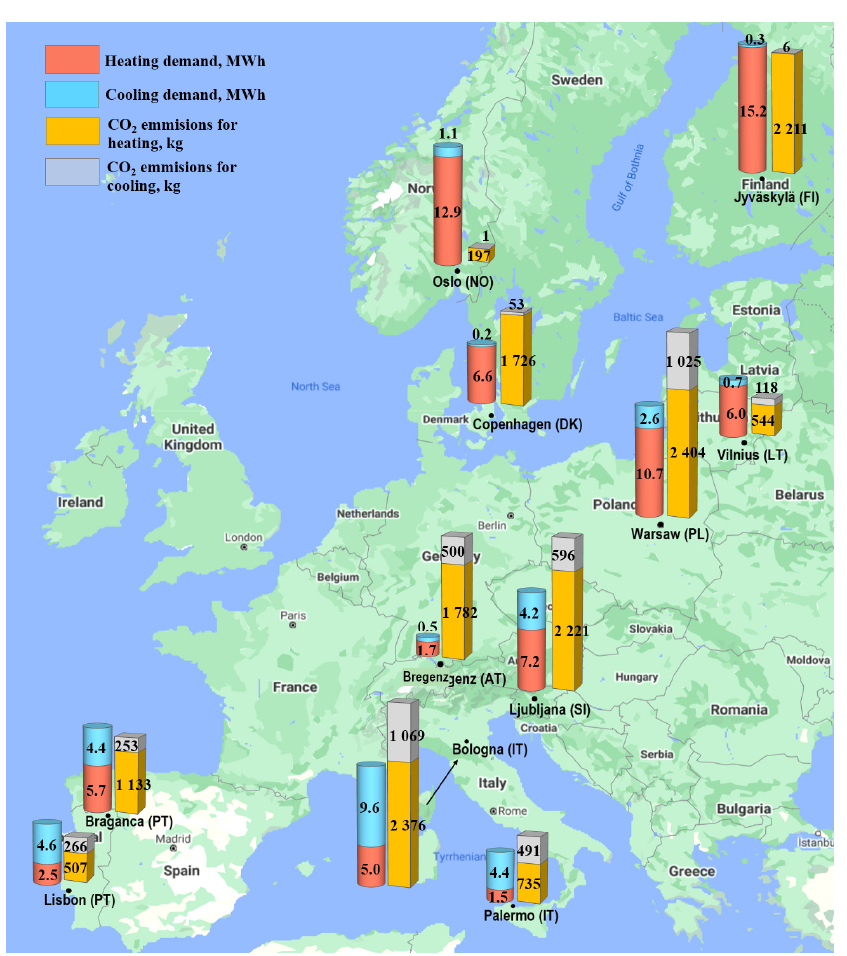
Figure 7. The aggregate primary energy demand for heating and cooling (MWh) in a building and the aggregate carbon dioxide emissions for heating and cooling (kg) using the same source of energy (natural gas for heating and electricity from RES and NER for cooling).